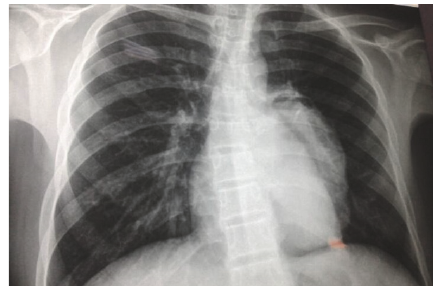
Figure 1: Front view chest X-ray showing a rounded prominence of the left cardiac border with the presence of a radiolucent rim at its superior aspect (crescent sign).